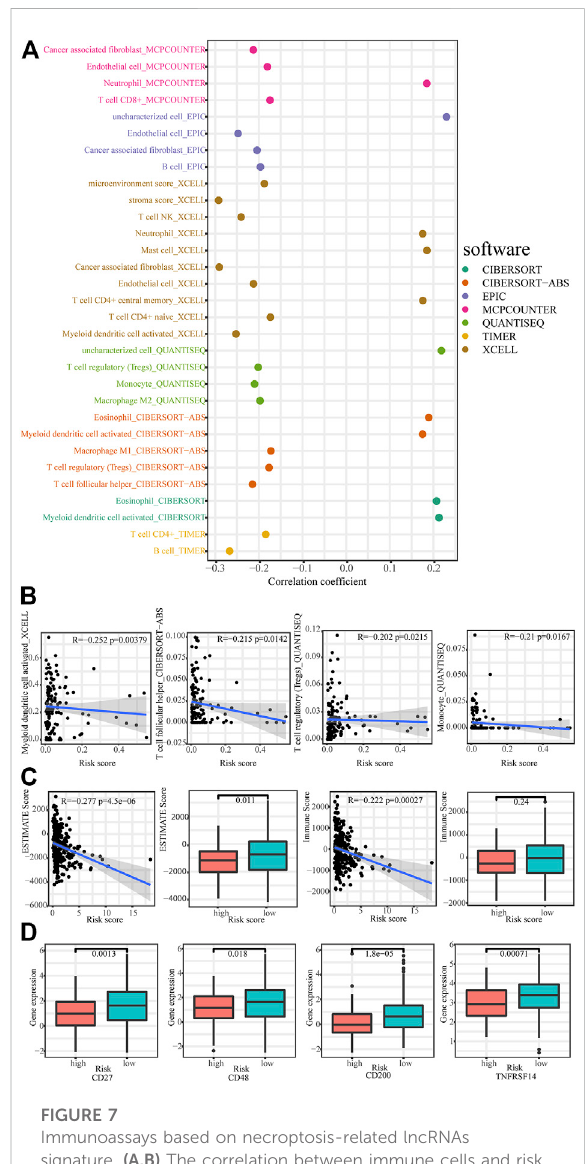
FIGURE 7 Immunoassays based on necroptosis-related lncRNAs signature. (A,B) The correlation between immune cells and risk scores. (C) Comparison of immune-related scores between low- and high-risk groups. (D) Comparison of checkpoints expression between low- and high-risk